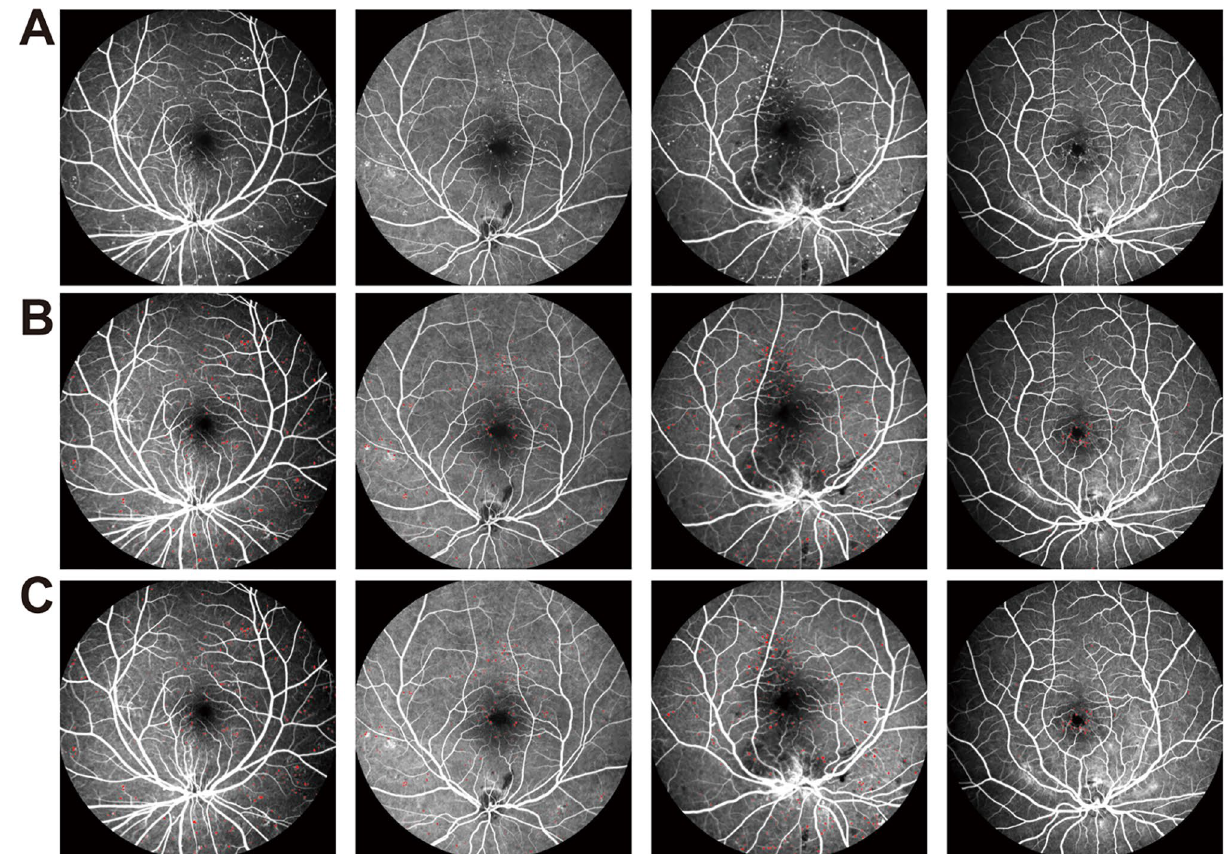
Figure 3. Detection results of MAs in FFA images. ( A ) Original FFA image; ( B ) detection results of MAs by MAs-FC-DenseNet; ( C ) ground